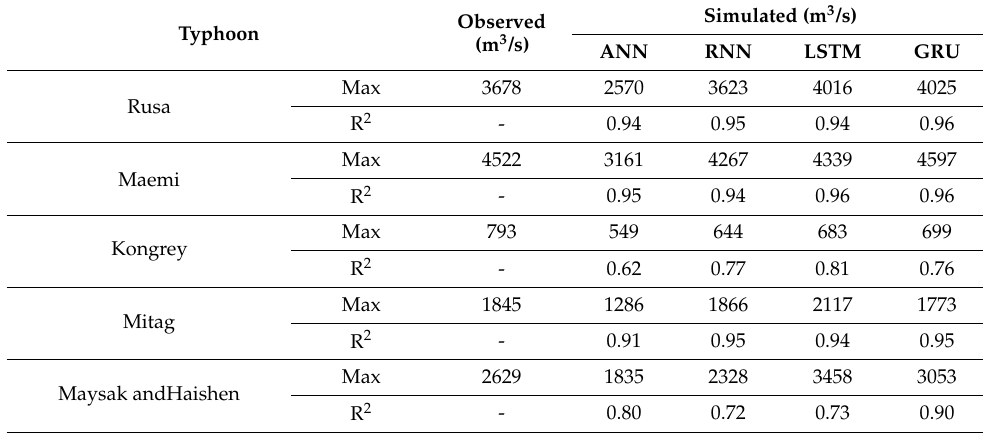
Table 10. Predicted inflow to Andong Dam by typhoon cases.